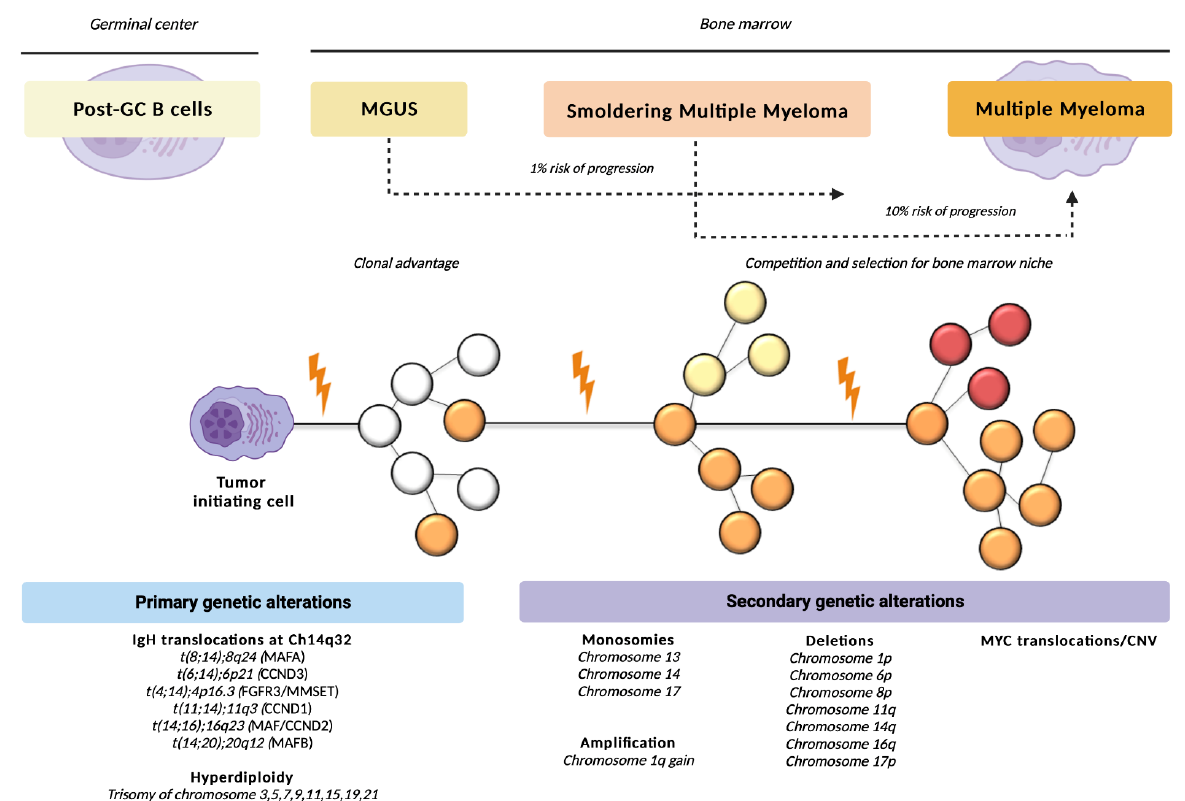
Figure 1. Genetic alterations involved in the pathogenesis of monoclonal gammopathies. Longitu- dinal evolution of cPCs according to current knowledge [13]. For the malignant transformation of a post-GC B cell to an MM cell, a genetic event is necessary, initiating the transition to the phase of MGUS. Malignant plasma cell accumulates new genetic mutations over time, acquiring growth ad- vantage in a subclone and leading to further expansion of some clones (orange/red) and to the ex- tinction of others (white, yellow). Abbreviations: cPCs, clonal plasma cells; post-GC, post-germinal center; MM, multiple myeloma; MGUS, monoclonal gammopathy of undetermined significance.